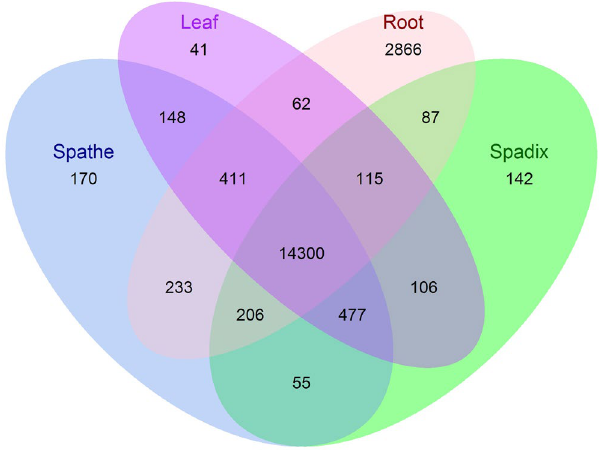
Figure 4. Venn diagram of A . amnicola expressed unigene number by organ. Unigenes expressed in roots, spathe, spadix, and leaves with maximum FPKM values ≥ 1 in one or more of the three biological replicates were defined as being expressed. Unigenes with maximum FPKM values = 0 for each replicate of a particular organ were defined as not being expressed in that